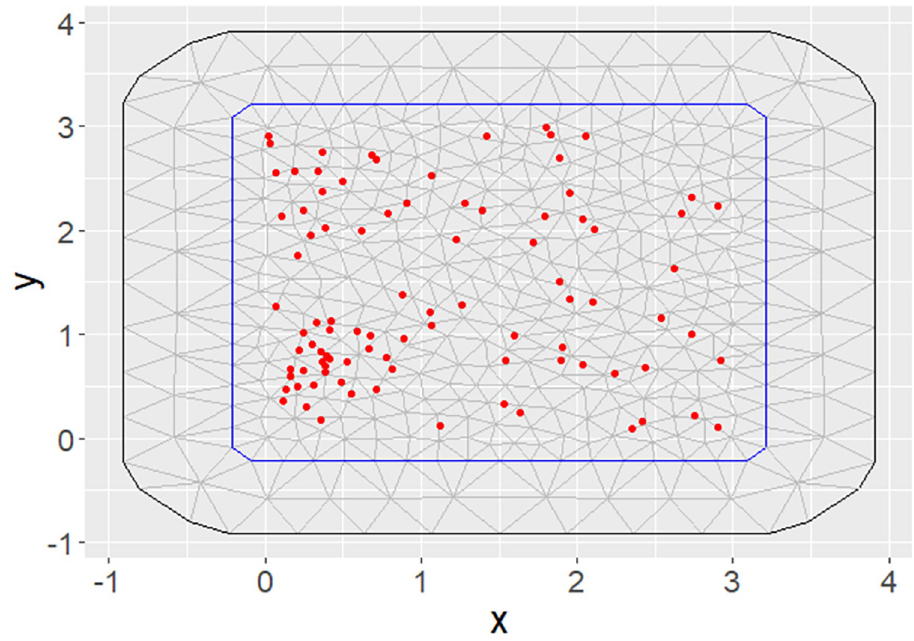
Fig 3. The interpolation grid for construction of the SPDE model.